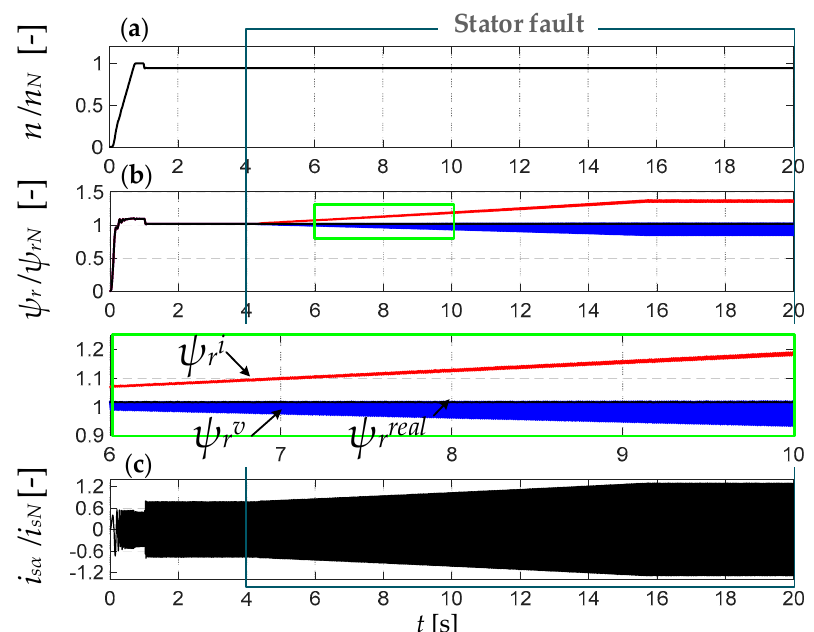
Figure 5. Operation of open-loop control scheme (v / f ) during inter-turn short circuit (ITSC): ( a ) rotor speed, ( b ) estimated and real rotor flux, ( c ) stator current in phase A; (simulation results), ( n ref = n N , T l = T N ).